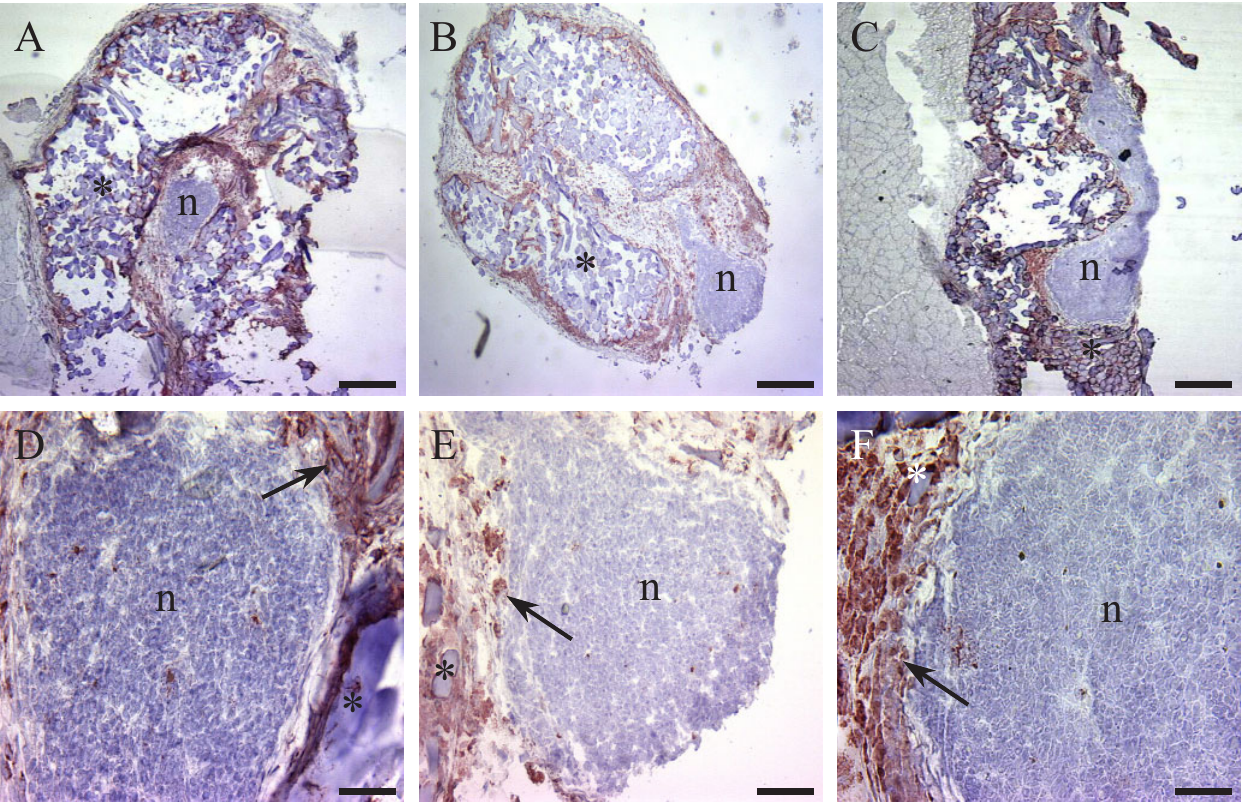
Figure 5 Light micrographs of coronal sections of the nerve guide explants immunocytochemically stained for ED1 (macrophages). (A), (B) and (C) represent week 7, 15 and 21, respectively. (D), (E) and (F) represent enlargements of biomaterial/nerve tissue interfaces for week 7, 15 and 21, respectively. n = nerve tissue; asterisks point at biomaterial; arrows point at ED1-immunopositive cells at the rim of the nerve tissue. Scale bars in (A), (B) and (C) represent 250 µ m; scale bars in (D), (E) and (F) represent 40 µ